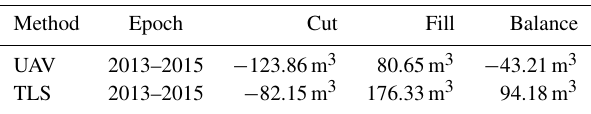
Table 5. Volume balance based on the UAV and the TLS data for the whole